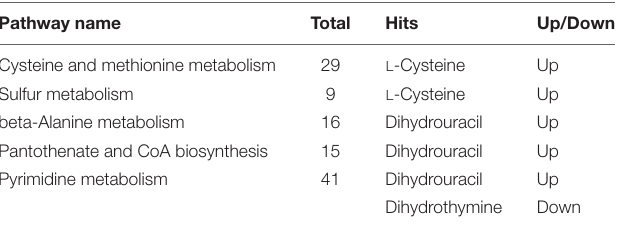
TABLE 6 | The most relevant metabolic pathways and corresponding differential metabolites in the liver of juvenile American eels of the OPC group in comparison with the HIS